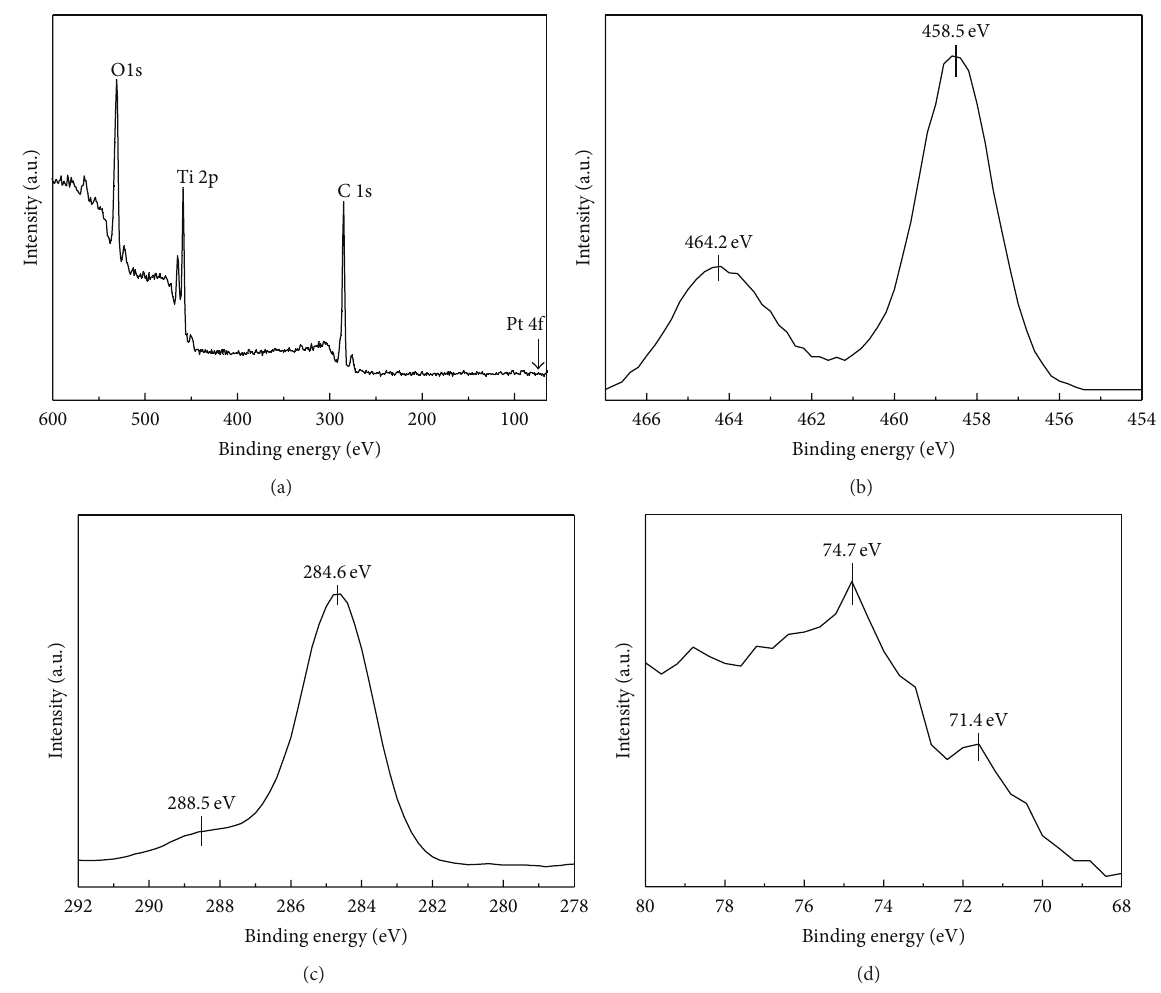
Figure 5: XPS spectra of 0.4 wt% Pt-C/TiO 2 (a), Ti 2p (b), C1s (c), and Pt 4f